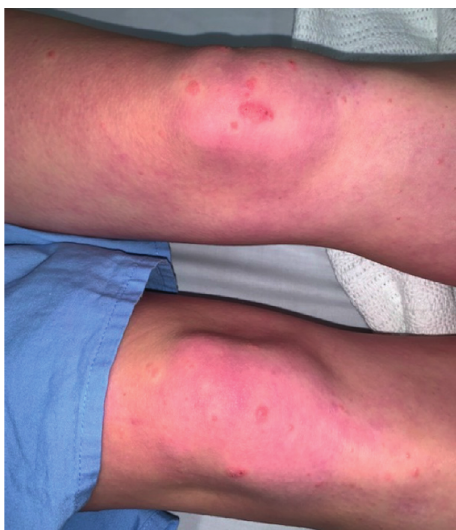
Figure 3: Bilateral knees.